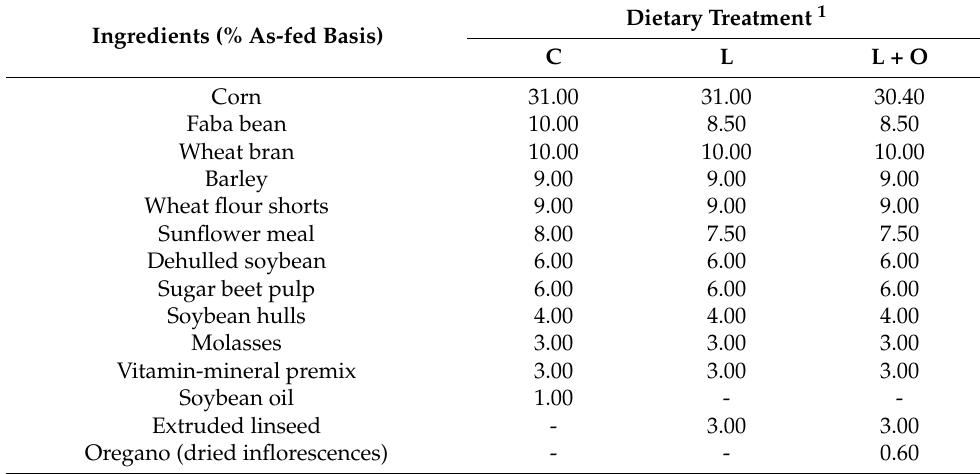
Table 1. Composition of the experimental